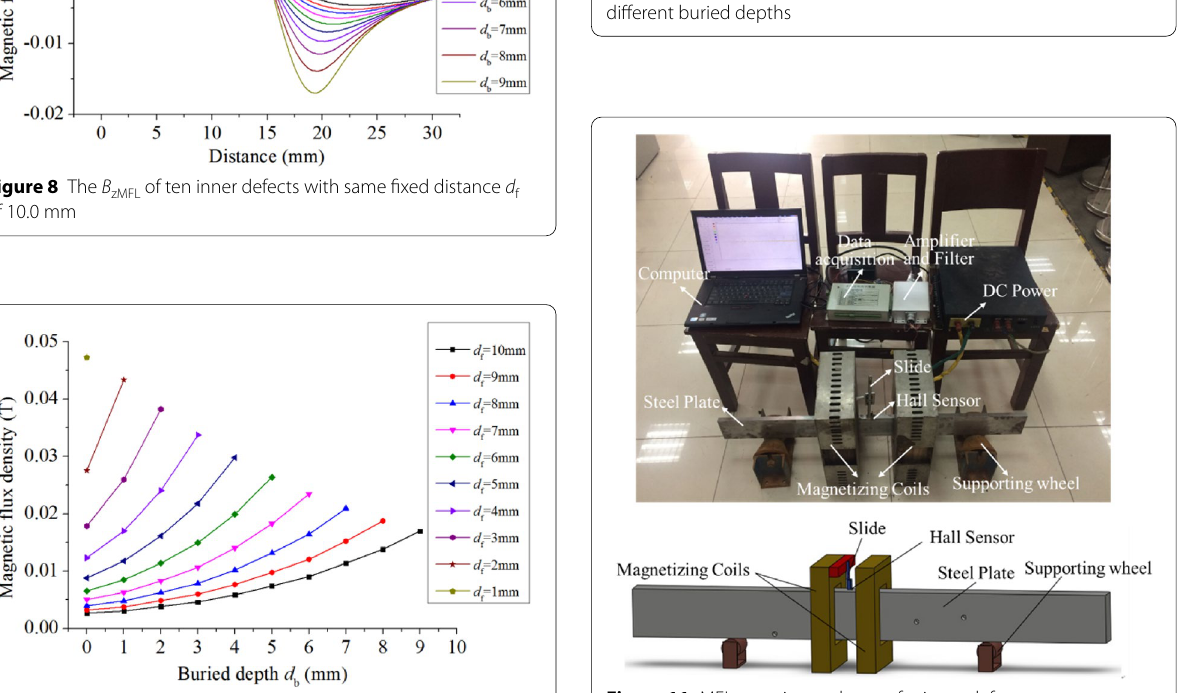
Figure 11 MFL experimental setup for inner